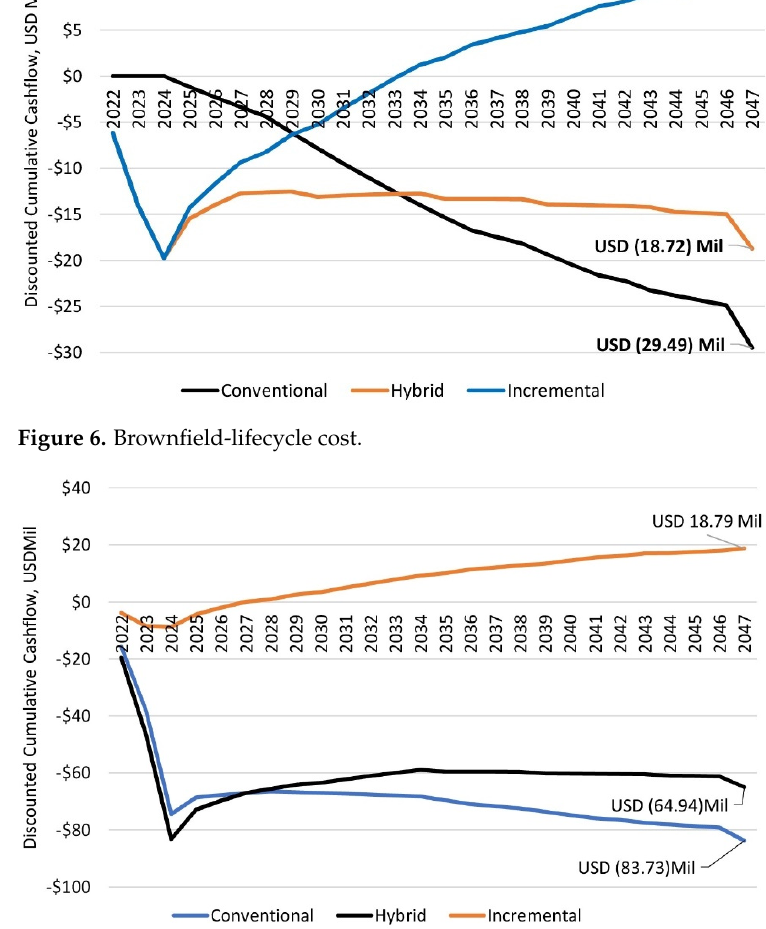
Figure 7. Greenfield-lifecycle